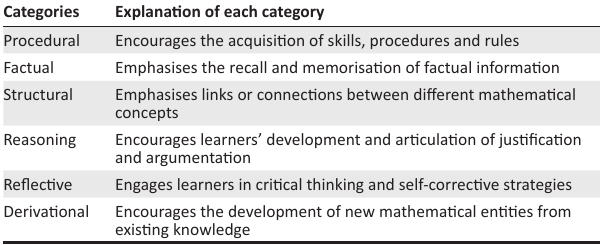
TABLE 1: Description of each category type.